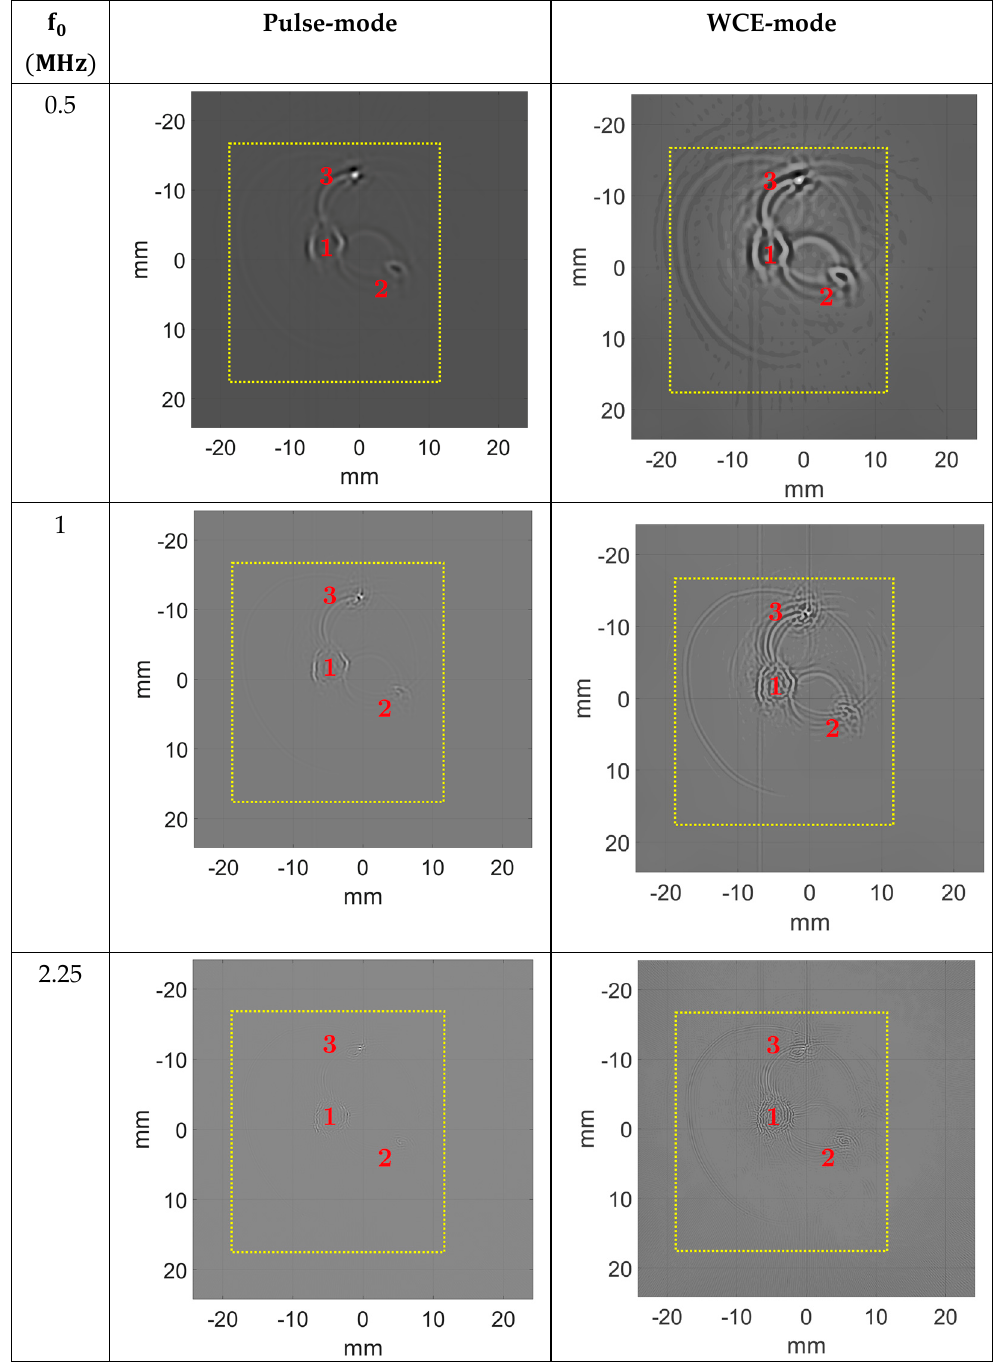
Figure 10. Reconstruction of the newborn arm phantom (True Phantom Solutions) (H1) obtained using reflection-mode USCT algorithm in pulse-mode ( left ) and WCE-mode ( right ), with 720 sig- nals and 65,536 samples per signal. Image size: 2048 × 2048 pixels 2 . (cid:1806)